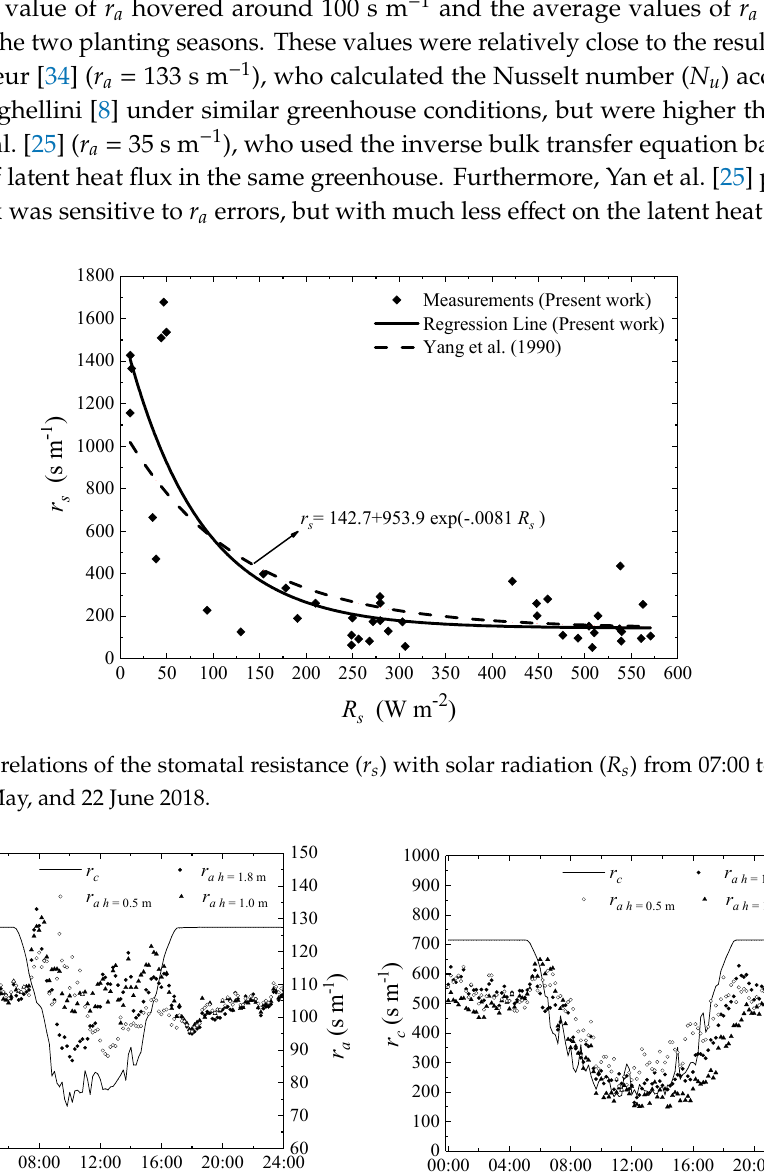
Figure 6. Average variations of r c and r a (s m − 1 ) in ( a ) the autumn planting season (from 2 to 10 November 2017) and ( b ) the spring planting season (from 2 to 10 May 2018). 3.3. E ff ects of Micrometeorological Data Observation Heights on the Performance of the SM The average variations of the measured and estimated T r values for nine consecutive days (2–10 November 2017 and 2–10 May 2018) in the middle growing stages of the cucumber plants are shown in Figure 7. The T r h = 0.5 m , T r h = 1.0 m , and T r h = 1.8 m represent the T r estimated by the SM using the micrometeorological data observed at heights of 0.5, 1.0, and 1.8 m above the ground, respectively. The variations in the T r values were not smooth during the daytime due to the variations in greenhouse energy caused by the R s inside the greenhouse sometimes being intercepted by